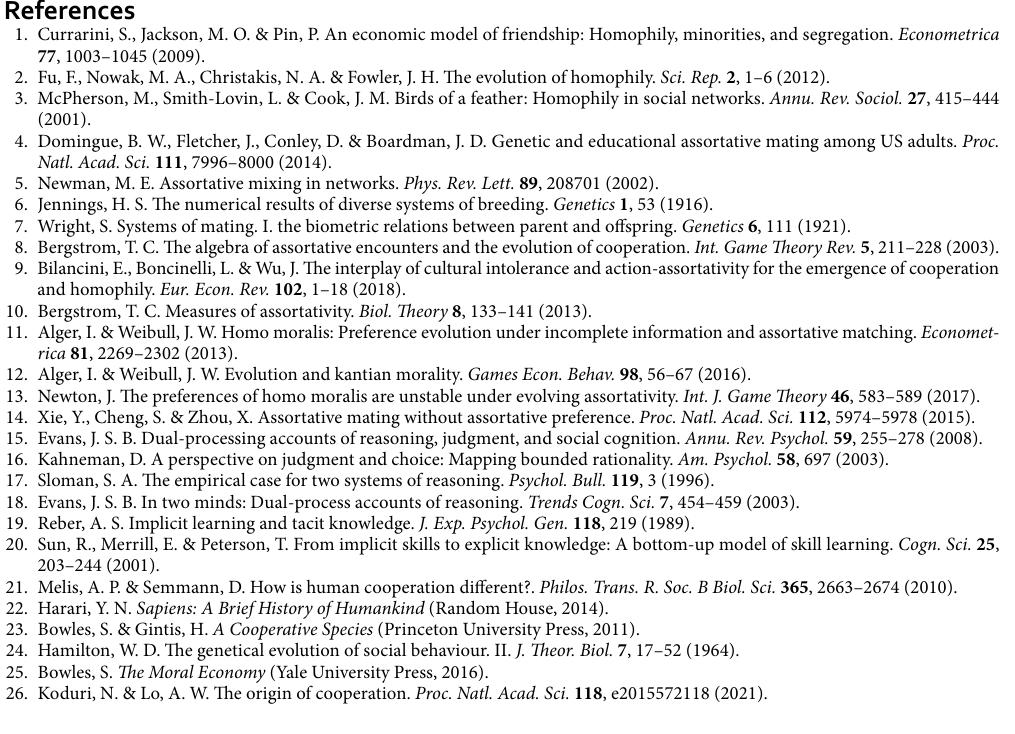
Figure 7 represents the cooperation rate under intuition, distinguishing between the empirical frequencies obtained through simulations and the theoretical frequencies resulting from the long-run Markov chain analysis. For most values of p and k , the theoretical analysis overlap with simulations, with only perceptible differences for cooperation rates that are very close to one. See the SI Appendix (Subsection 2.2) for more details on this.